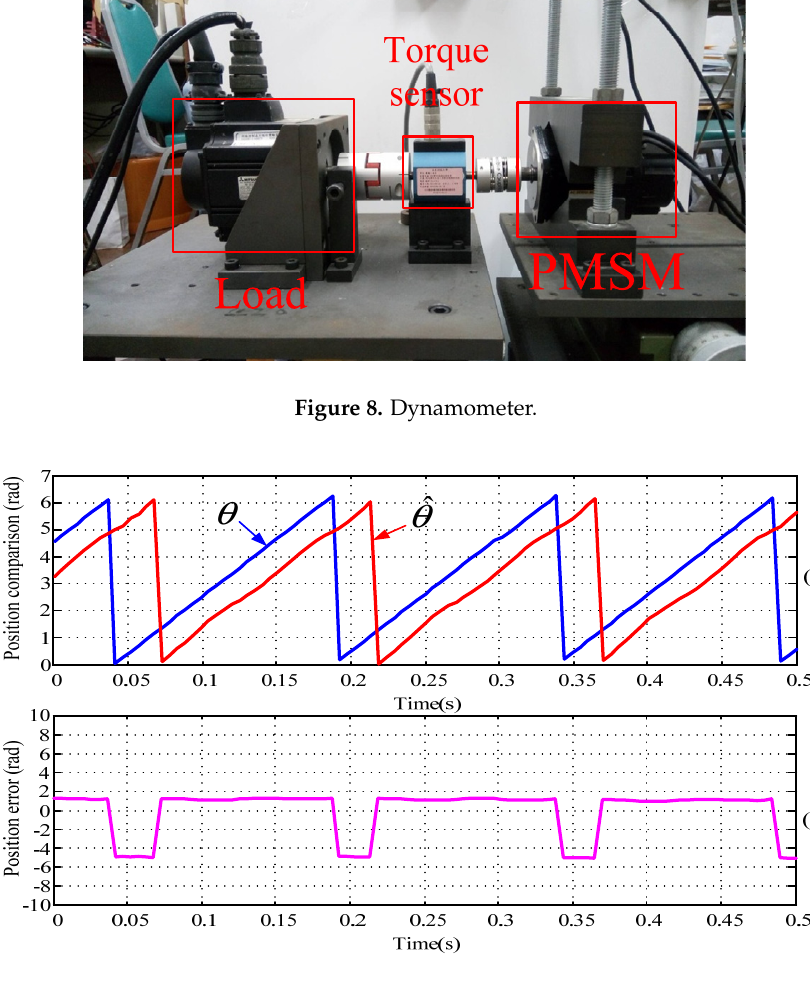
Figure 9. The rotor angle at the motor speed of 100 rpm ( a ) encoder output ( θ ) and rotor angle estimation (ˆ θ ) by ISMO, and ( b ) the estimation error.